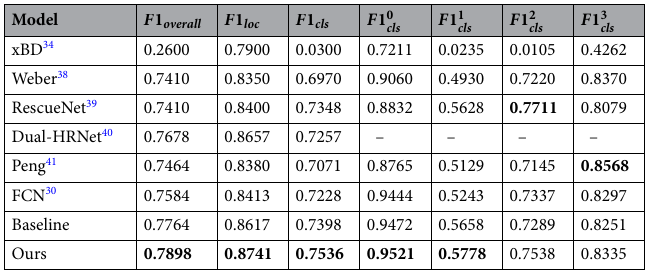
Table 4. Overall building damage assessment results. Significant values are in